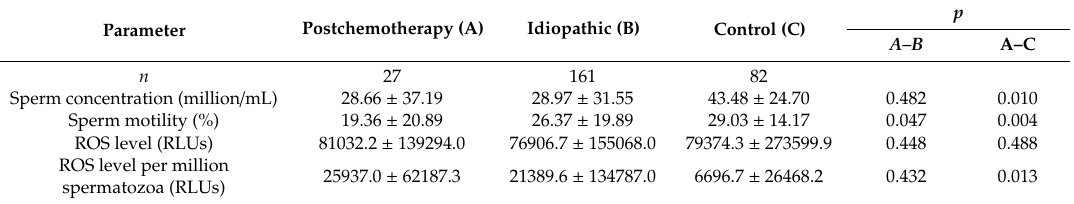
Table 2. Sperm parameters and ROS production levels between both groups positive for